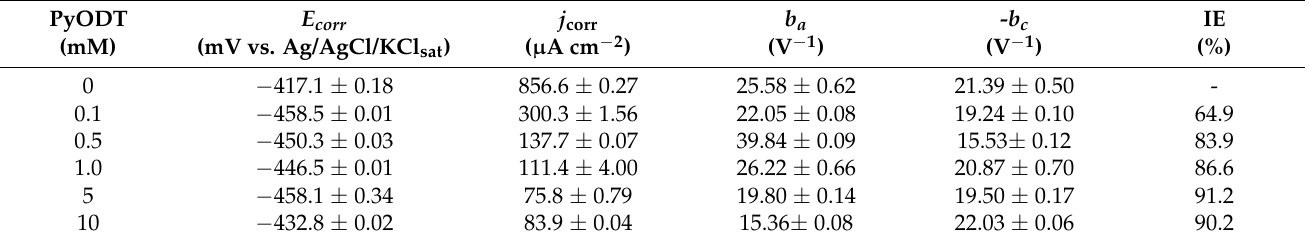
Table 1. Electrochemical parameters of C-steel in 1 M HCl solution, in the absence and the presence of various concentrations of PyODT, determined from the polarization